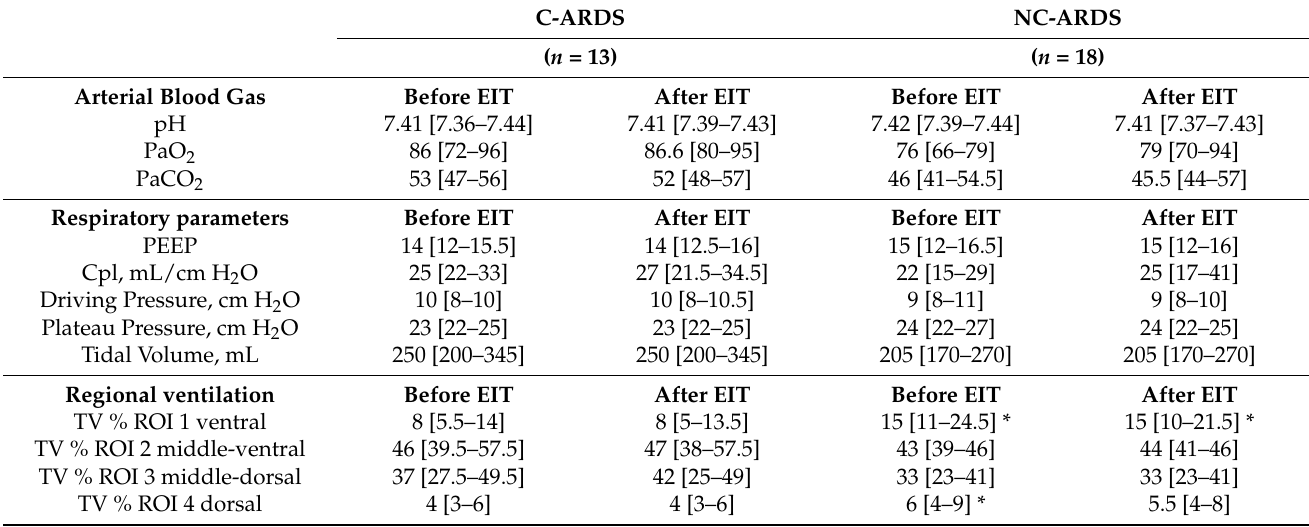
Table 3. Arterial blood gases, respiratory parameters, and regional distribution of ventilation before and after the EIT exams.